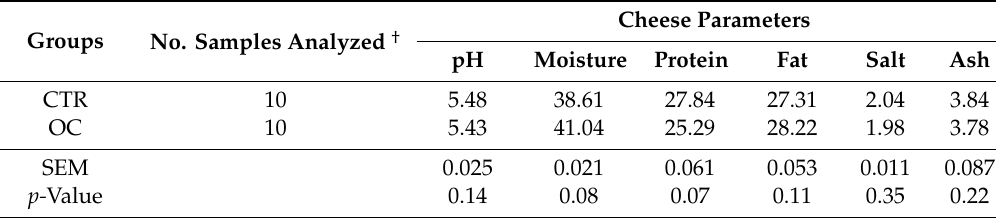
Table 6. E ff ect of olive cake supplement on gross composition of the cheese after 60 days of ripening. Groups No. Samples Analyzed †